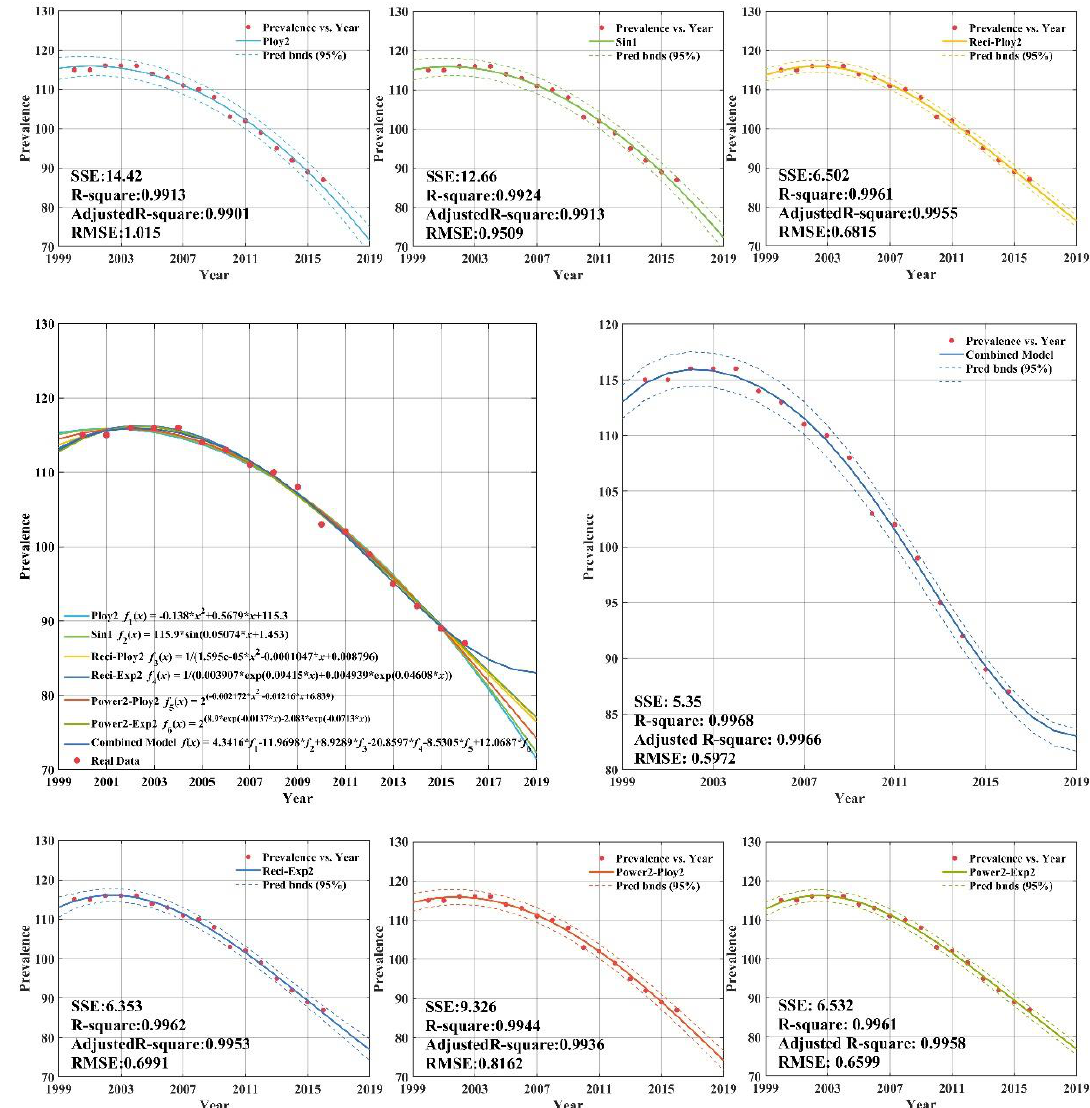
Figure A2. Fitting curves and forecasting for the upper-middle income group.